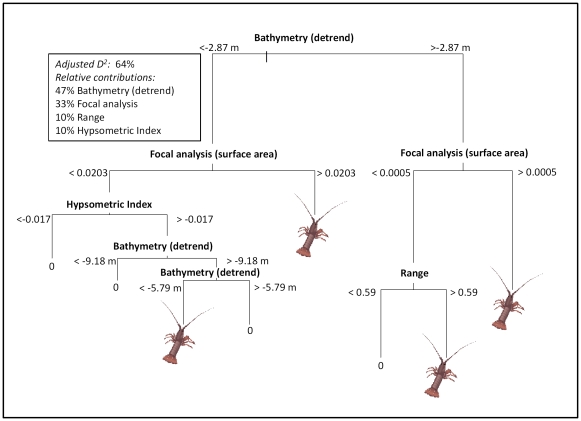
Final classification tree model for the presence/absence of western rock lobster, Panulius cygnus.Focal analysis was calculated based on standard deviation of surface area over a 7 m kernel radius. Hypsometric Index and Range were calculated over a 12.5 m and 62.5 m kernal radius, respectively. Bathymetry (detrend) was the most influential variable, contributing to 47% of the variation explained, followed by focal analysis (33%), range (10%) and hypsometric index (10%).